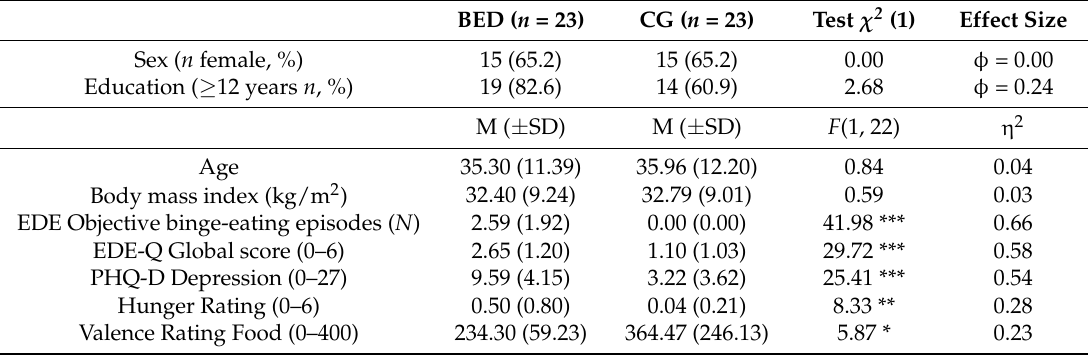
Table 1. Sample characteristics and group differences in psychopathology, hunger, and valence ratings of food